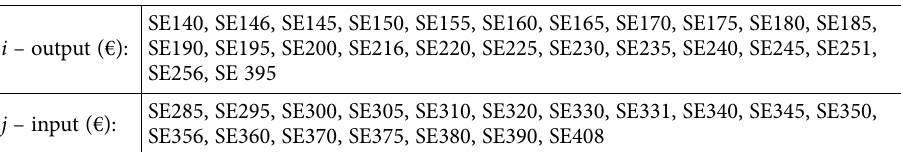
Table 1. Input-output codes for the representative farm in EU Farm Accountancy Data Network [EU- FADN] (source: EU Farm Accountancy Data Network [EUFADN], (10.10.2017). http://ec.europa.eu/